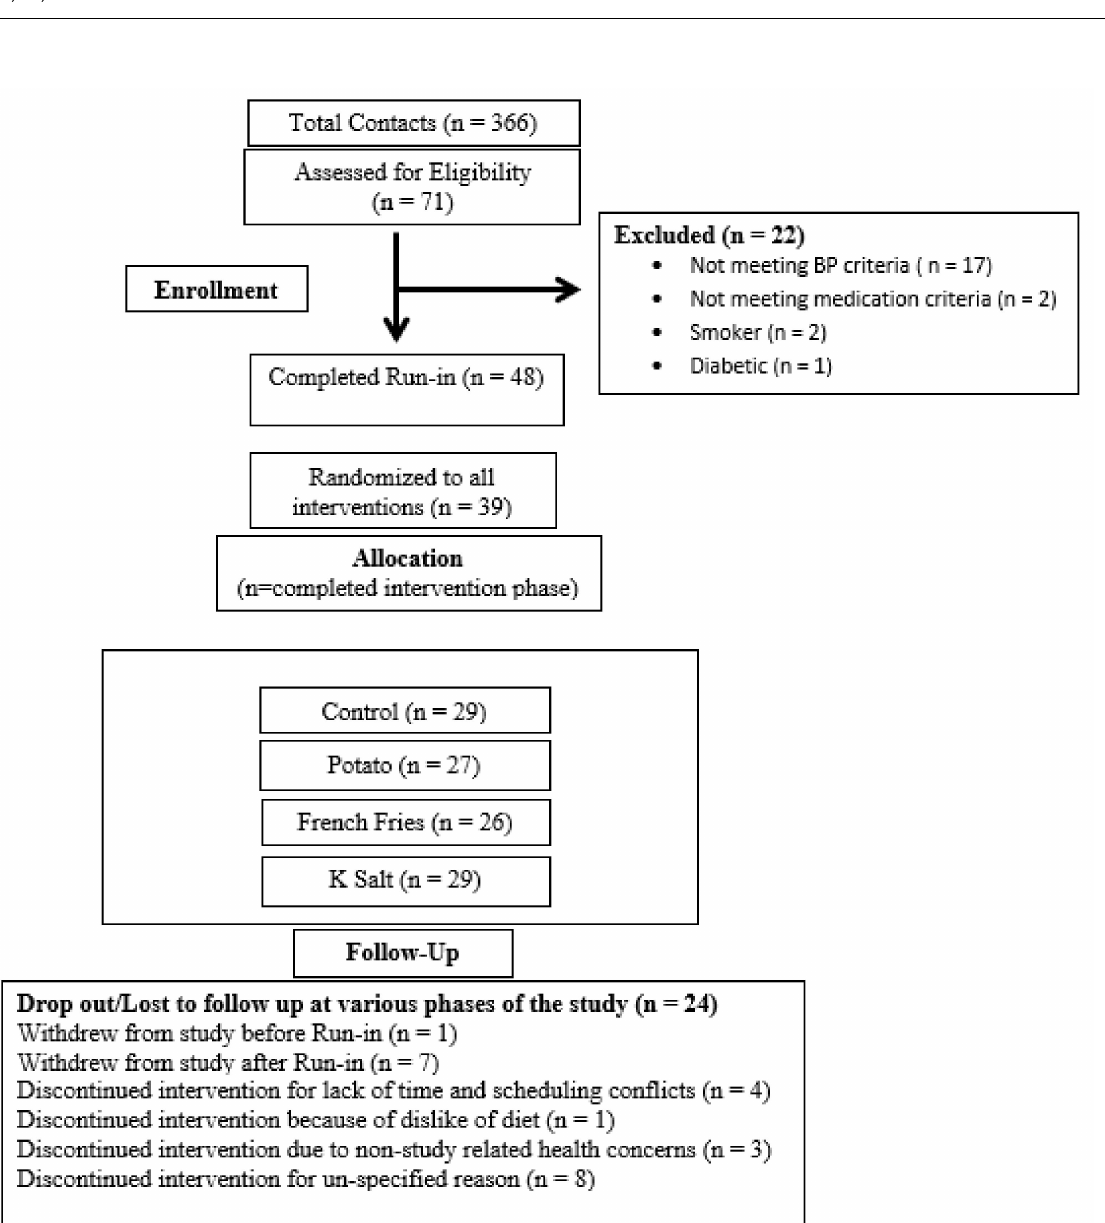
Figure 1. Flow Diagram of Potassium Hypertension and Retention